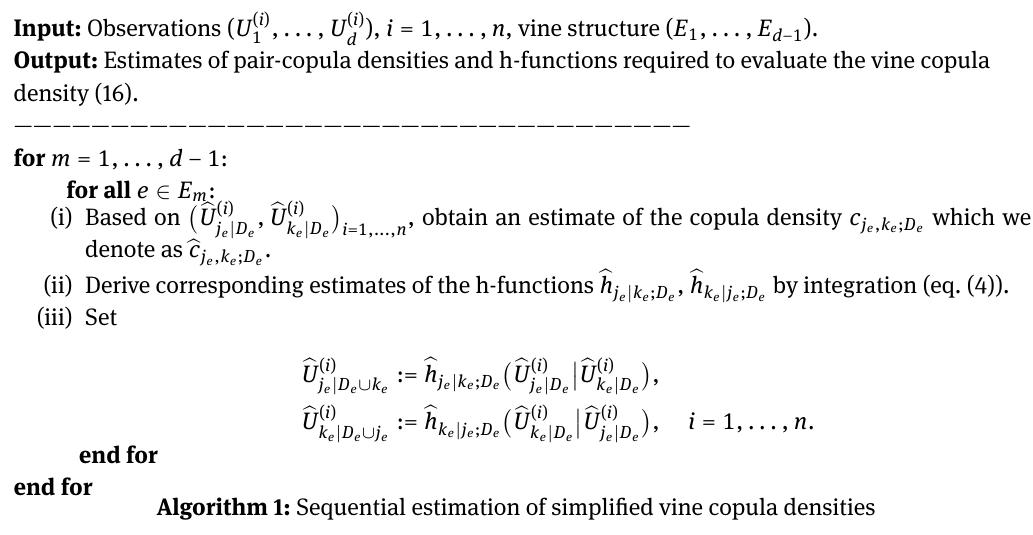
Algorithm 1: Sequential estimation of simplified vine copula